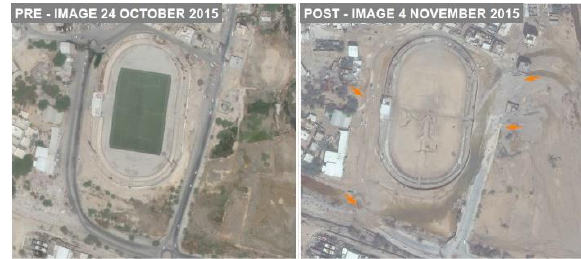
Figure 2. Destruction of road and infrastructure in the Al Mukalla city (Photos from the web).